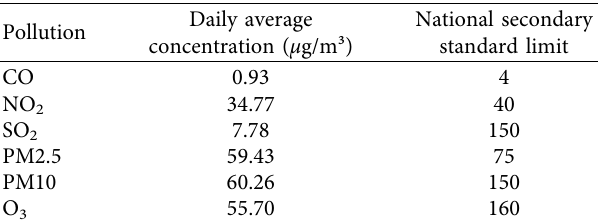
Table 3: Daily average concentration of pollutants in winter of 2019 in